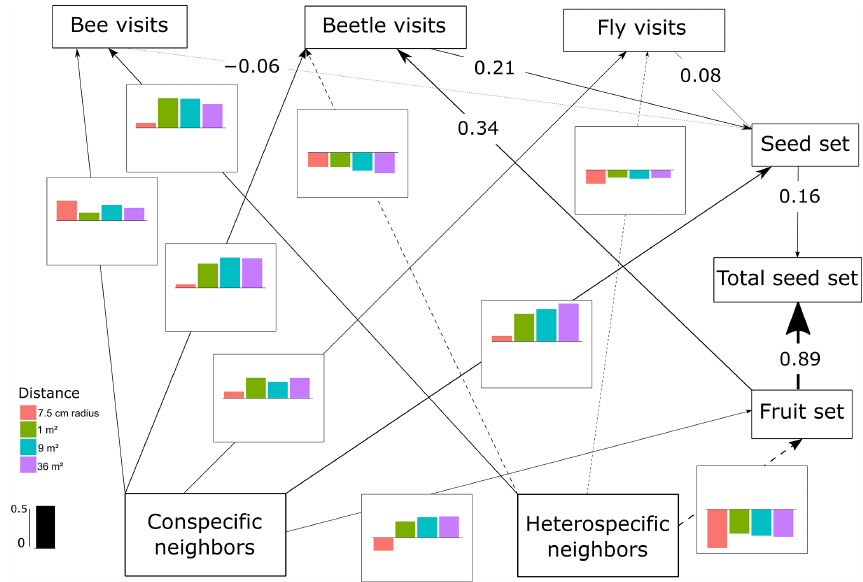
Figure 3. SEM of L. maroccanus , which includes the differences in the interactions between scales. The lines (dashed and solid lines) are proportional to the magnitude of the relationship (when different scales are relevant, we plot the mean of the standardized total effects across scales). The dashed lines represent negative relationships. When numbers are included on the paths instead of in the plot with the effect size bars across scales, it describes the standardized total effect, which remains the same across scales. The bar plots show the standardized total effects of each relationship across the different scales, and the bar in the legend represents the value of 0.5 as a visual aid. If the value of the bar plot is positive, it means that it has a positive effect, and if it is negative, it means that it has a negative effect. It is important to mention that the correlations between the variables are not visualized on the path, but in the SEM they are included (Eq. A2, Appendix A) ( p value = 0.659; df = 44; R 2 of individual total seed set =∼